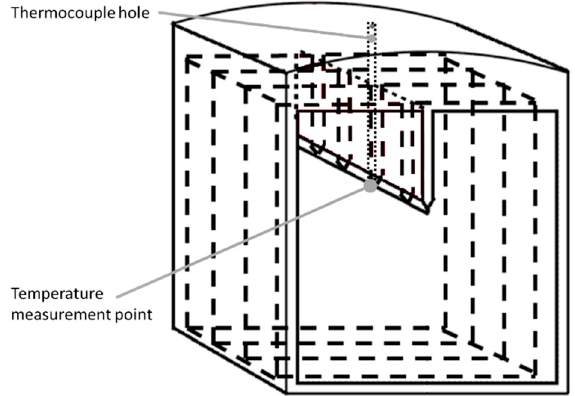
Figure 1. Slice of billet for heat treatment with a thermocouple hole and the position of CT sample collection.